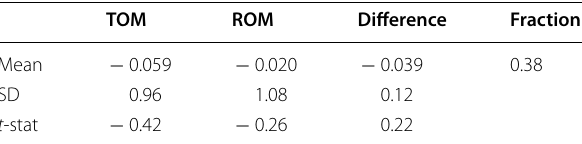
Table 8 T-test of means for “Turn-of-the-Month-Effect” of year